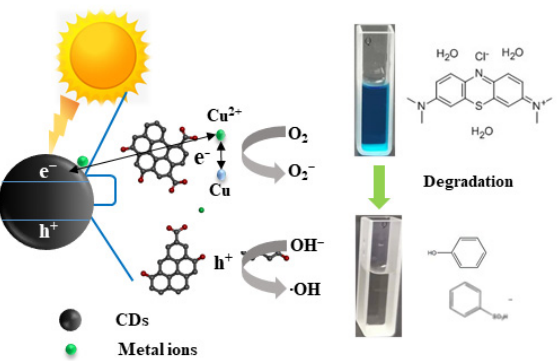
Table 1. Carbon dot synthesis from different precursors and their